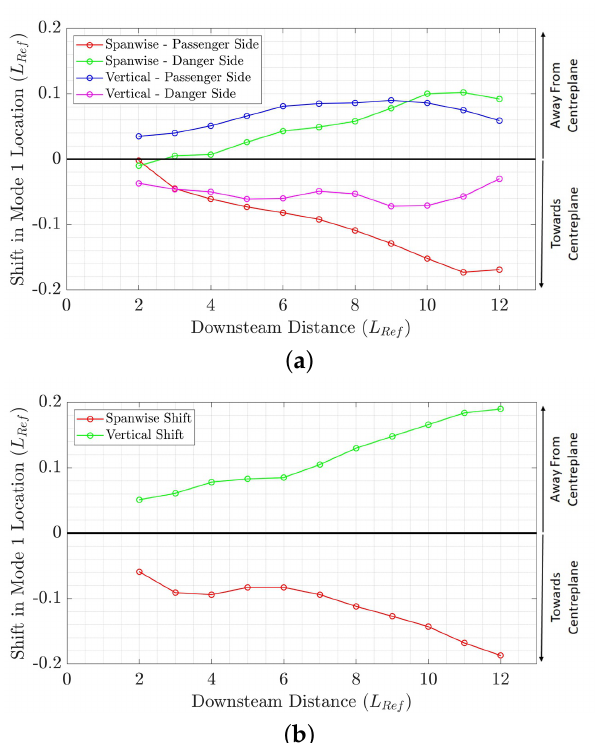
Figure 8. Shift in location of mode 1 slipstream energy for ( a ) parallel fins and ( b ) circulation